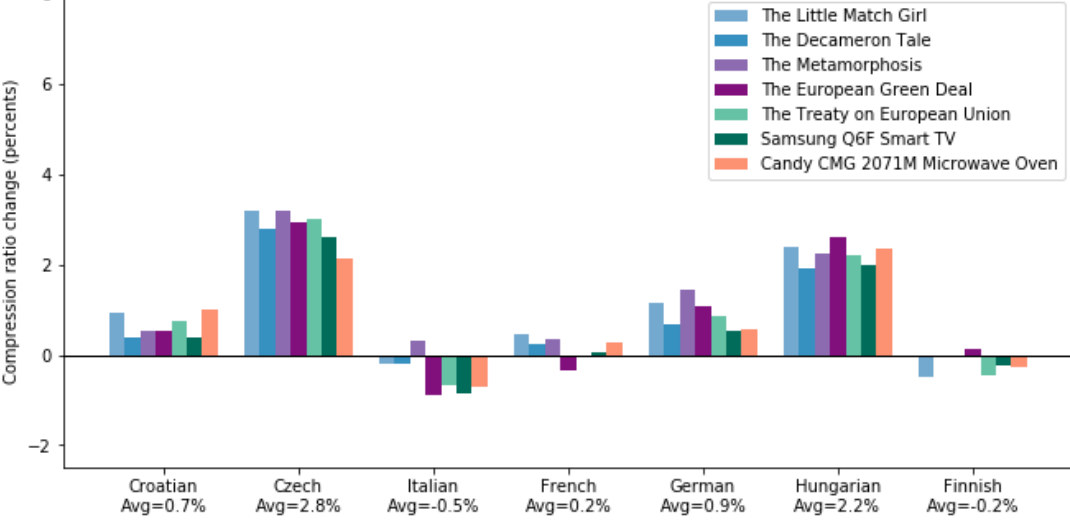
Figure 11. Compression ratio change compared to English—Arithmetic compression (positive percentages signify larger compressed file size when compared to English).